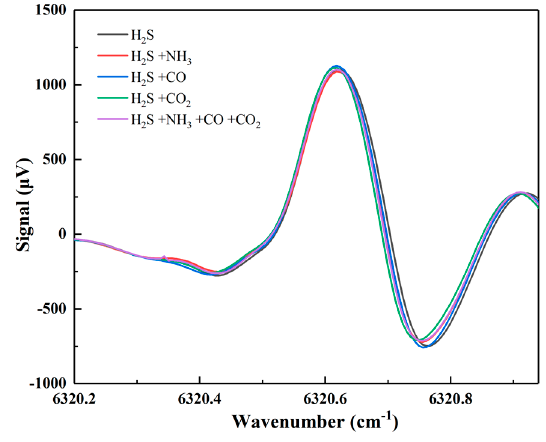
Figure 5. The 2f WMS PAS signal of mixtures of H 2 S, NH 3 , CO, and CO 2, at concentrations mimicking the sewer gas mixtures, at room temperature and atmospheric pressure.